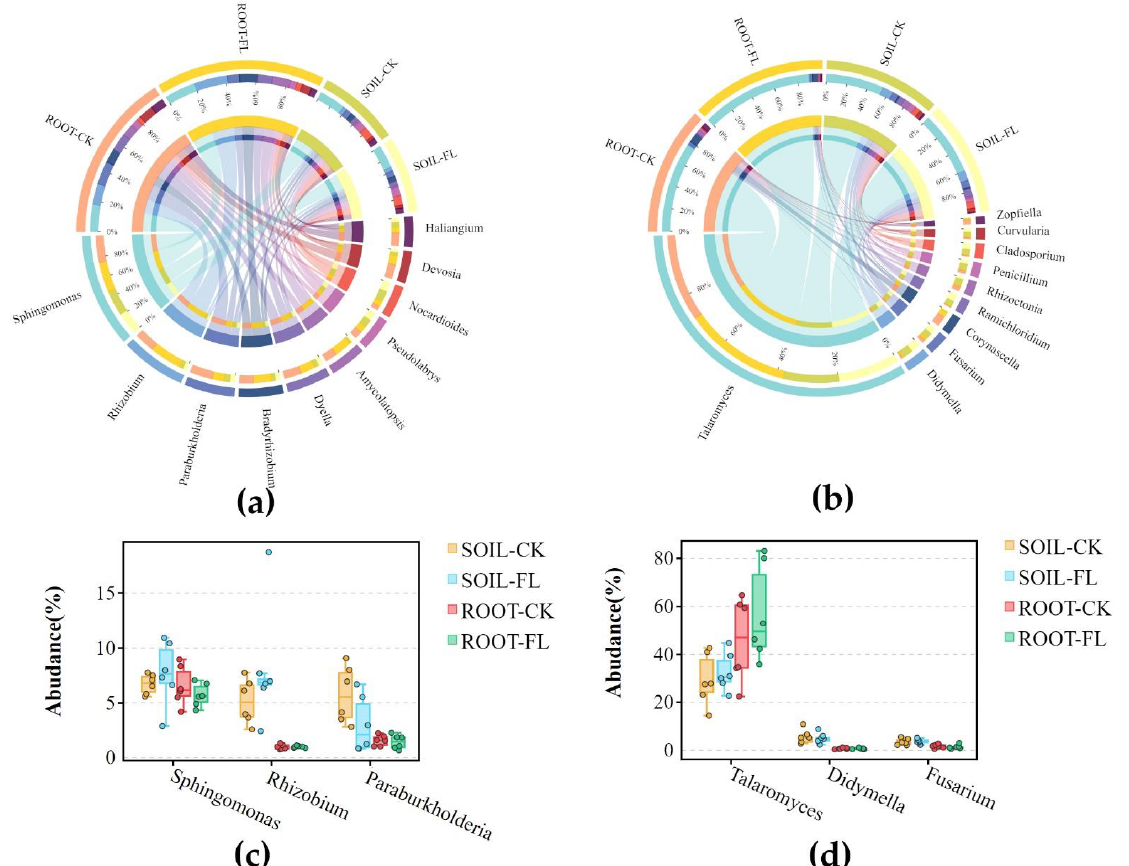
Figure 4. Microbial community composition and taxa (genera) of the top three biomarker species of bacteria and fungi at the genus level. ( a , b ) Top 10 abundant bacterial and fungal genera in soil and roots in the CK and FL groups. The colors of the upper half of the circle indicate the different sample groups, and the color of the lower half of the circle indicates the main genera. The colors of the outermost ring of the lower half of the circle indicate the genera, and the innermost ring of the circle indicates the abundance of the genera in the different groups. The thickness of the lines connecting genera to samples indicates the abundance of the genera in particular samples. ( c , d ) Biomarker genus abundance analysis for bacteria and fungi by Tukey’s